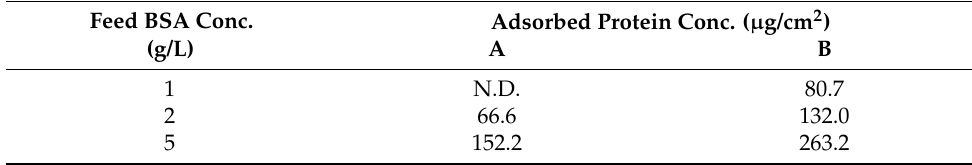
Table 4. Adsorbed protein concentration onto the filter after the final